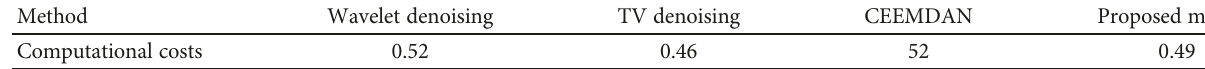
Table 2: Computational costs of four signal processing methods for simulated signal.